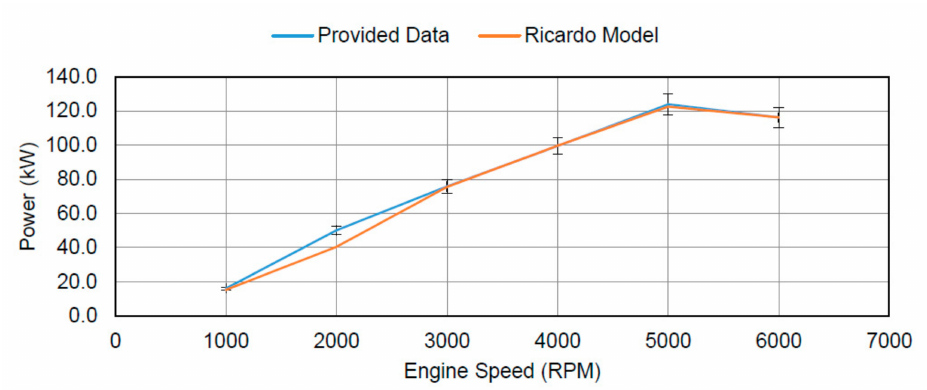
Figure 13. Comparison between provided engine torque and Ricardo WAVE model.